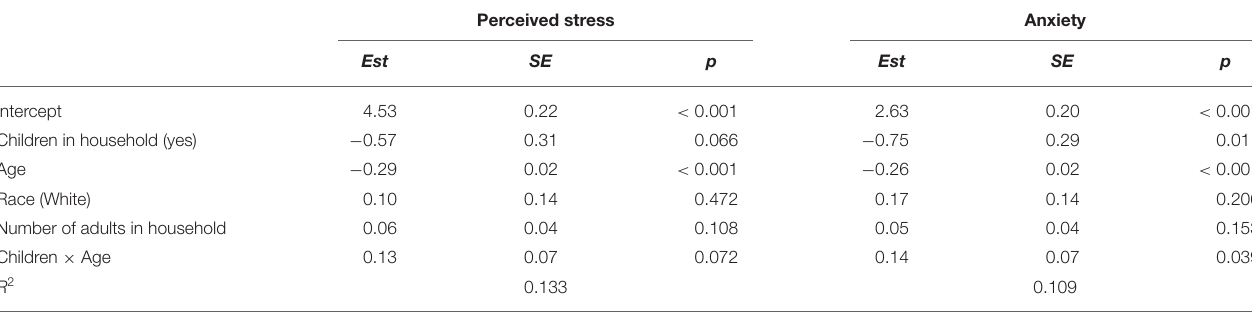
TABLE 2 | Multiple regression models estimating the extent to which having children in the household is associated with perceived stress and